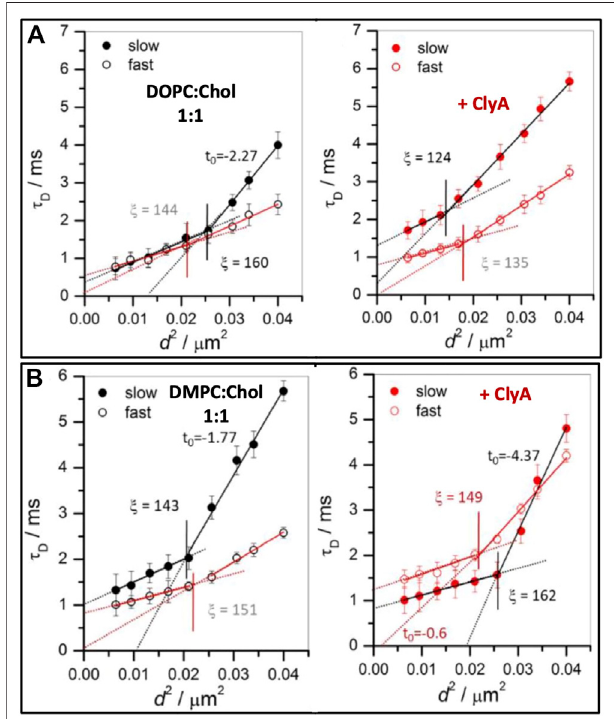
FIGURE11 | Illustrates FCS diffusion law plots, transit time ( τ d ) vs. d 2 for (A) DOPC:Chol (1:1) and (B) DMPC:Chol (1:1) SLBs before (left panel) and after (right panel) ClyA addition. The slow and fast regimes are represented by closed and open symbols. The solid lines in the respective panels are thelinear fi tusing Eq.10 andthedottedlinesaretheextrapolated linetoshow the intercept. The vertical lines, in respective panels, demarcates the crossover length scale, ξ , separating different dynamical regimes whether Brownian or non-Brownian diffusion. Adapted from Sarangi and Basu (2018).